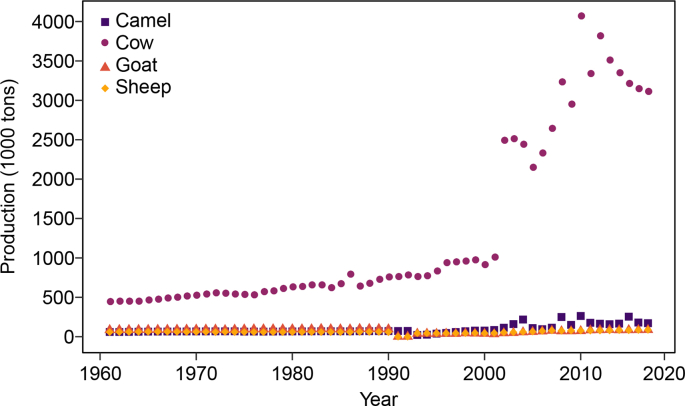
Milk production in Ethiopia, by animal species (FAO, 2019).